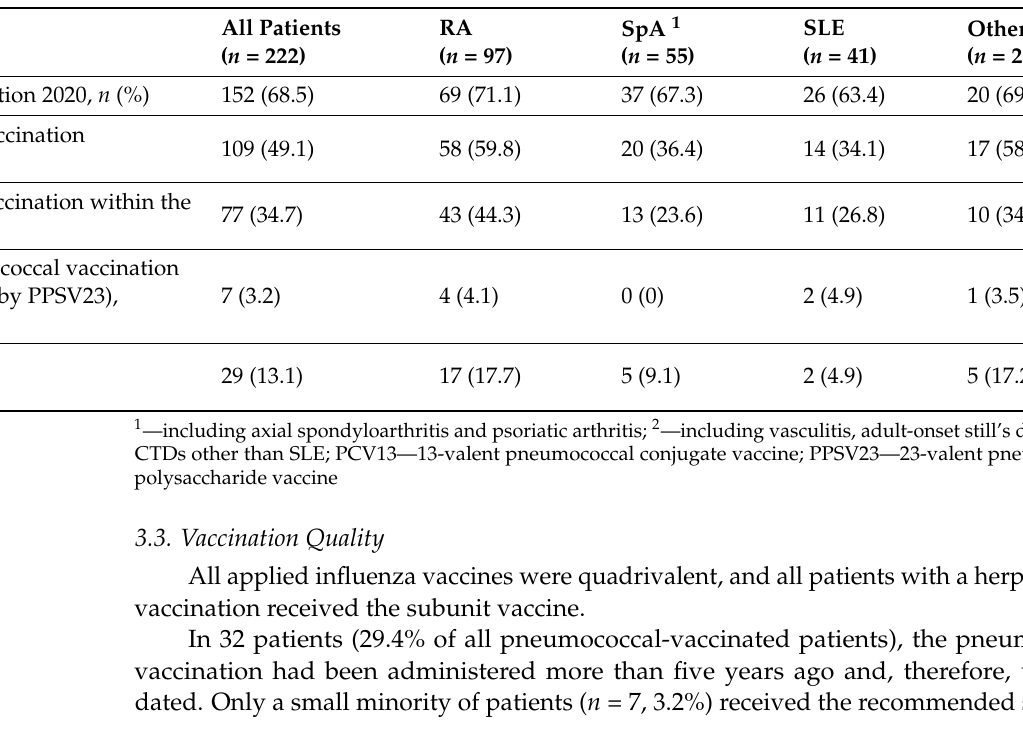
Table 2. Vaccination coverage and